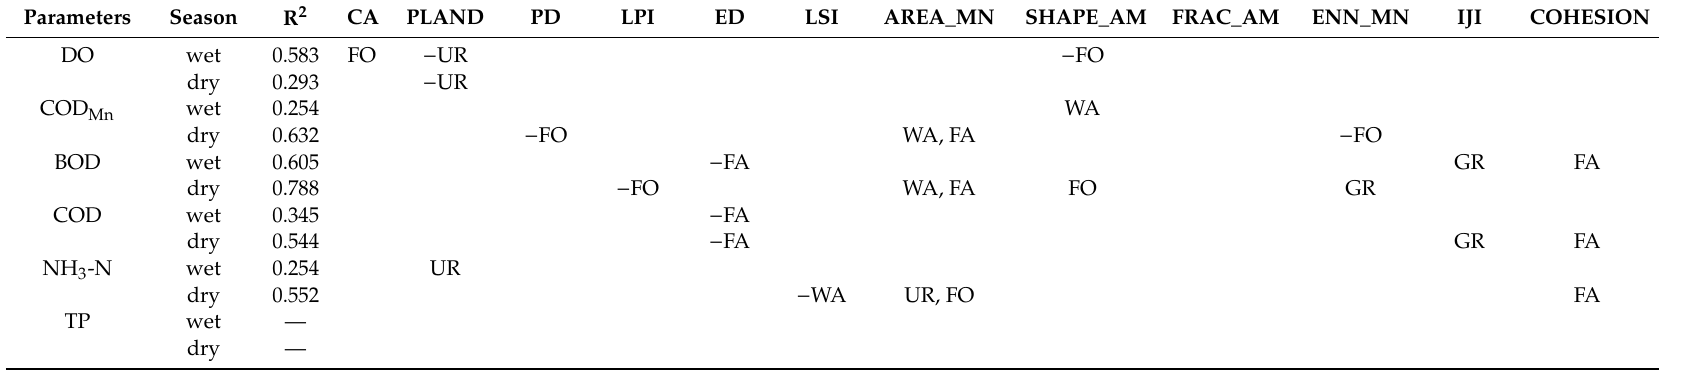
Table 6. Relationships between configuration of land use patterns and water quality parameters.